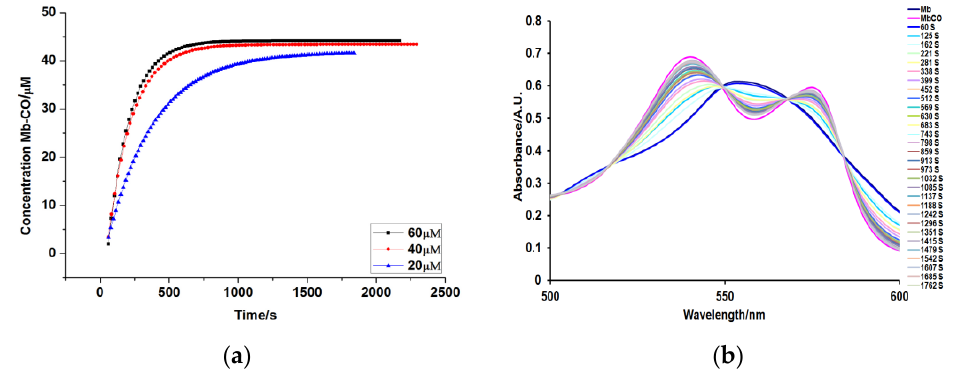
Figure 2. Photo-activated CO release profile for 4 ( a ) UV-vis spectrum showing the Q-bands during the conversion of deoxy-Mb to Mb-CO with time while the concentration of CO-RMs is 60; ( b ) The CO-releasing kinetics of 4 in which [Mb-CO] was plotted with CO-RM at 60, 40, 20 µ M against